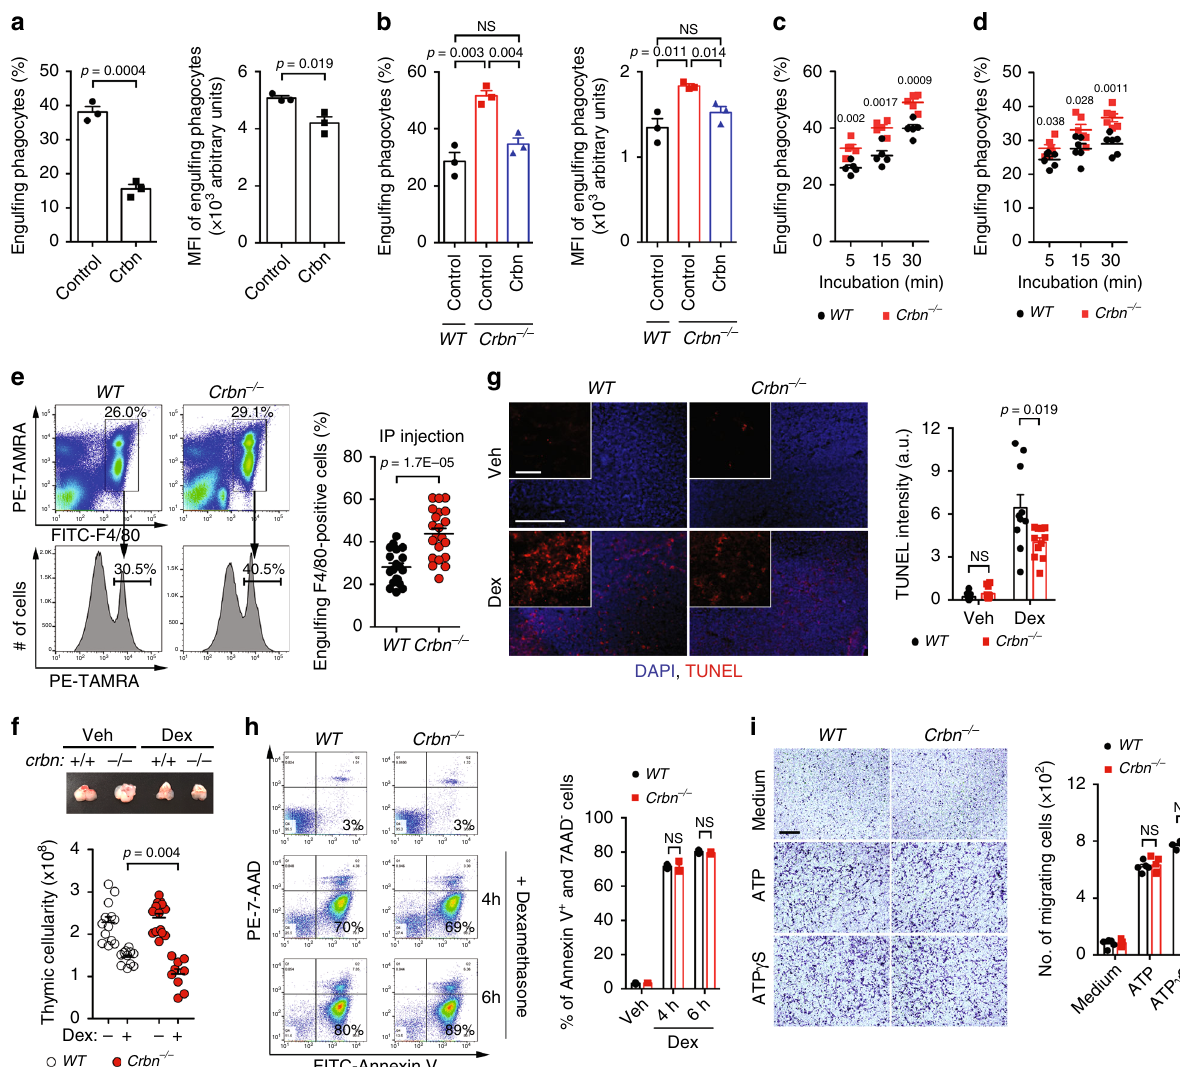
Fig. 1 Crbn negatively regulates phagocytosis of apoptotic cells. a LR73 cells transfected with Crbn were incubated with TAMRA-stained apoptotic cells for 2 h and analyzed by fl ow cytometry. n = 3 experiments, mean ± SEM (two-tailed unpaired Student t test). b MEFs derived from WT or Crbn − / − mice or Crbn − / − MEFs transfected with Crbn were incubated with TAMRA-stained apoptotic cells for 2 h and analyzed by fl ow cytometry. n = 3 experiments, mean ± SEM. NS, not signi fi cant (one-way ANOVA). c , d BMDMs ( c , n = 5 mice) or peritoneal macrophages ( d , n = 6 mice) derived from Crbn − / − or WT mice were incubated with TAMRA-stained apoptotic cells for the indicated durations and analyzed by fl ow cytometry, mean ± SEM. The numbers in the graphs indicate p values (two-way ANOVA). e TAMRA-stained apoptotic cells were peritoneally injected into WT ( n = 19 mice) or Crbn − / − ( n = 21 mice) mice. At 15 min after injection, peritoneal exudates were stained with F4/80 and analyzed by fl ow cytometry. n = 3 experiments, mean ± SEM (two-tailed unpaired Student t test). f Mice were intraperitoneally injected with 250 µ g dexamethasone dissolved in PBS. At 4 h after injection, the sizes of the thymi were observed (top) and the number of thymocytes in the thymi was counted (bottom). n = 5 experiments (each dot represents one mouse), mean ± SEM (two-way ANOVA). g The thymi of the mice f were stained with TUNEL. Microscopy images were acquired (left) and the intensity of TUNEL was measured with ImageJ (right). Scale bar, 250 or 50 µ m (inset). n = 3 experiments (each dot represents one slide), mean ± SEM (two-tailed unpaired Student t test). h Thymocytes from the indicated mice were incubated with 50 µ M dexamethasone for the indicated duration, stained with Annexin V and 7-AAD, and analyzed by fl ow cytometry. n = 3 experiments, mean ± SEM. NS, not signi fi cant (two-tailed unpaired Student t test). i BMDMs from the indicated mice migrating to 100 nM ATP or ATP γ S were measured using the transwell cell migration assay. Scale bar, 200 µ m. n = 4 experiments, mean ± SEM. NS, not signi fi cant (Two-tailed unpaired Student t